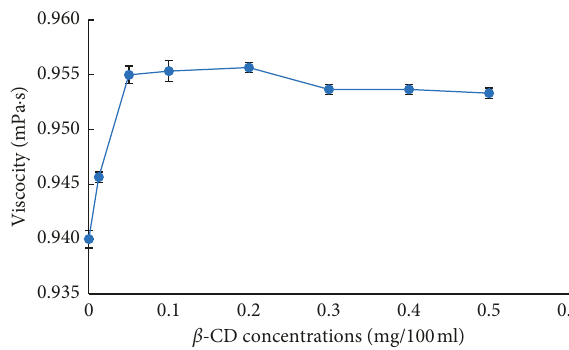
Figure 3: Effects of β -CD concentrations on viscosity of tea infusion.